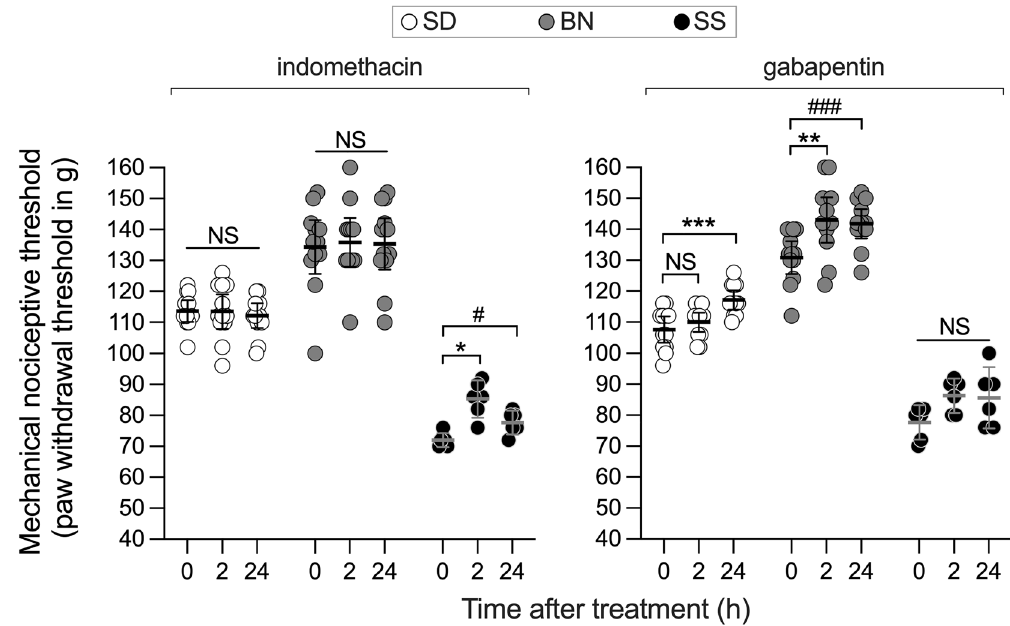
Figure 8. Effect of pharmacological treatments on the SS hyperalgesic phenotype. SS (closed symbols), SD (open symbols) and BN (gray symbols) rats were evaluated in the Randall-Selitto test to determine their baseline hindpaw withdrawal threshold. In sequence, a single injection with the NSAID indomethacin (left panel, 2 mg/ kg, s.c.) or gabapentin (right panel, 100 mg/kg, i.p.) was performed. Mechanical nociceptive thresholds were evaluated 2 h and 24 h later. We found that the effect of either indomethacin or gabapentin was significantly different across the strains (F (2, 27) = 95.81; F (2, 27) = 207.0, respectively, p < 0.0001 for both, two-way repeated measures ANOVA followed by Bonferroni posttest). Left panel: While injection of indomethacin produced a was observed on SD or BN rats ( p > 0.9999, NS, for both). Right panel: In contrast, treatment with gabapentin affected both SD (*** p = 0.0004) and BN (** p = 0.0101; ### p = 0.0091) rats. However, no significant change in